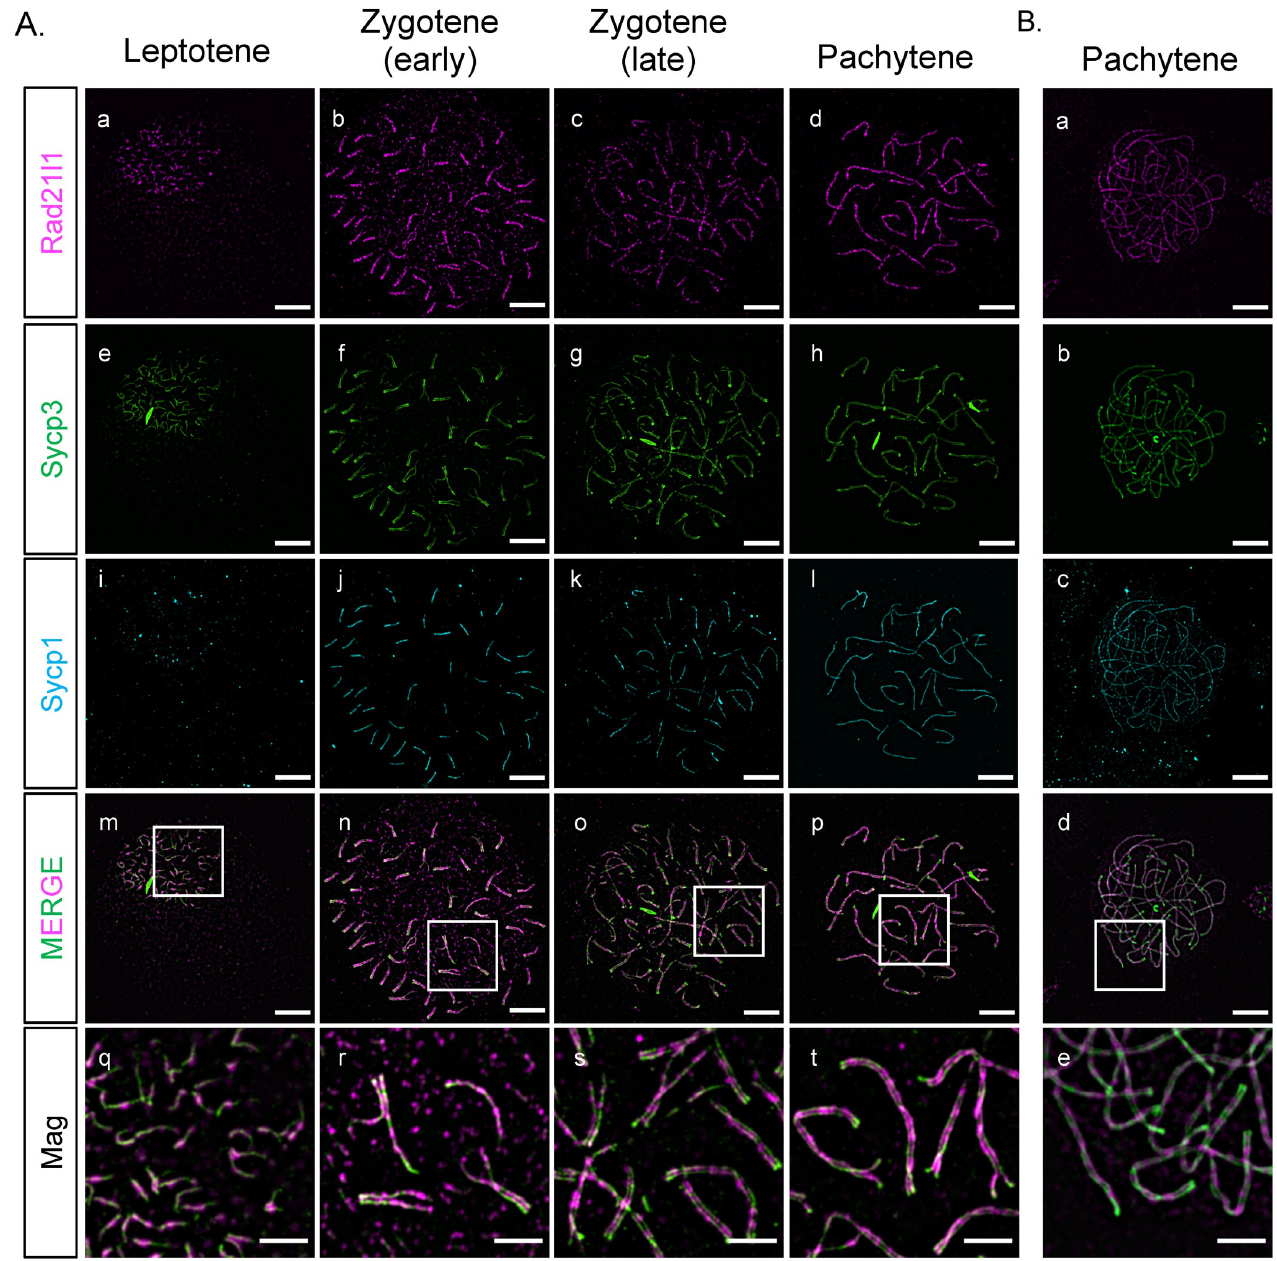
Fig 1. Rad21l1 expression and loading. (A) Rad21l1 loading during prophase I of meiosis in spermatocyte nuclear surface spreads. Rad21l1 (magenta) loads onto chromosome axes simultaneously with Sycp3 (green) and is also dispersed as foci throughout the spread in leptotene. In early zygotene, Sycp1 (cyan) lines start near the telomeres and synapsis extends inward through late zygotene and are present end-to-end along axes. Note: there is some asynapsis in the pachytene nucleus which may indicate that the cell was either in very early or very late pachytene. The merged images are Rad21l1 and Sycp3 channels only. Mag images are magnifications from the Merge panels; the regions magnified are indicated by white boxes. Panel series a-p scale bar = 5 μ m. Mag panel series q-t scale bar = 2 μ m. (B) Rad21l1 loading during prophase I of meiosis in oocyte nuclear surface spreads. Panels a-e are arranged similarly to the corresponding panels of part